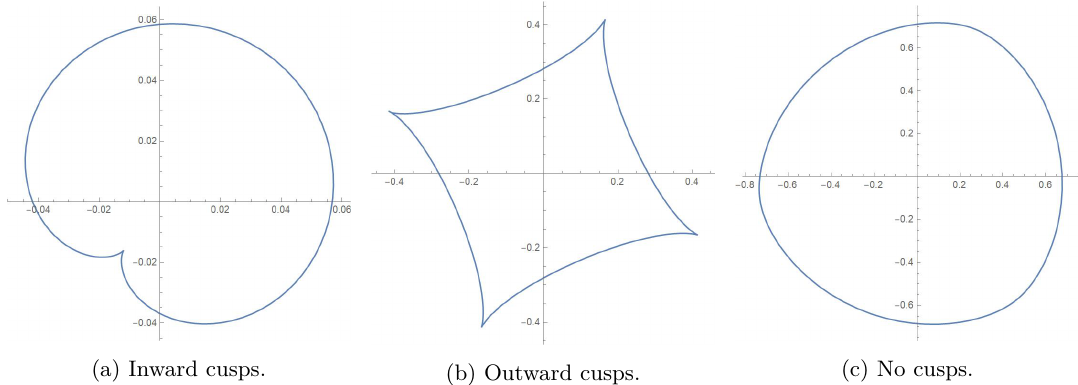
Figure 3 . Examples from each of the three types of solutions in the Larsan-Sanchez class that are shifted by an imaginary half-period. The origin of the plots is that of the static patch and the axes measure the dimensionless coordinate distance r/l